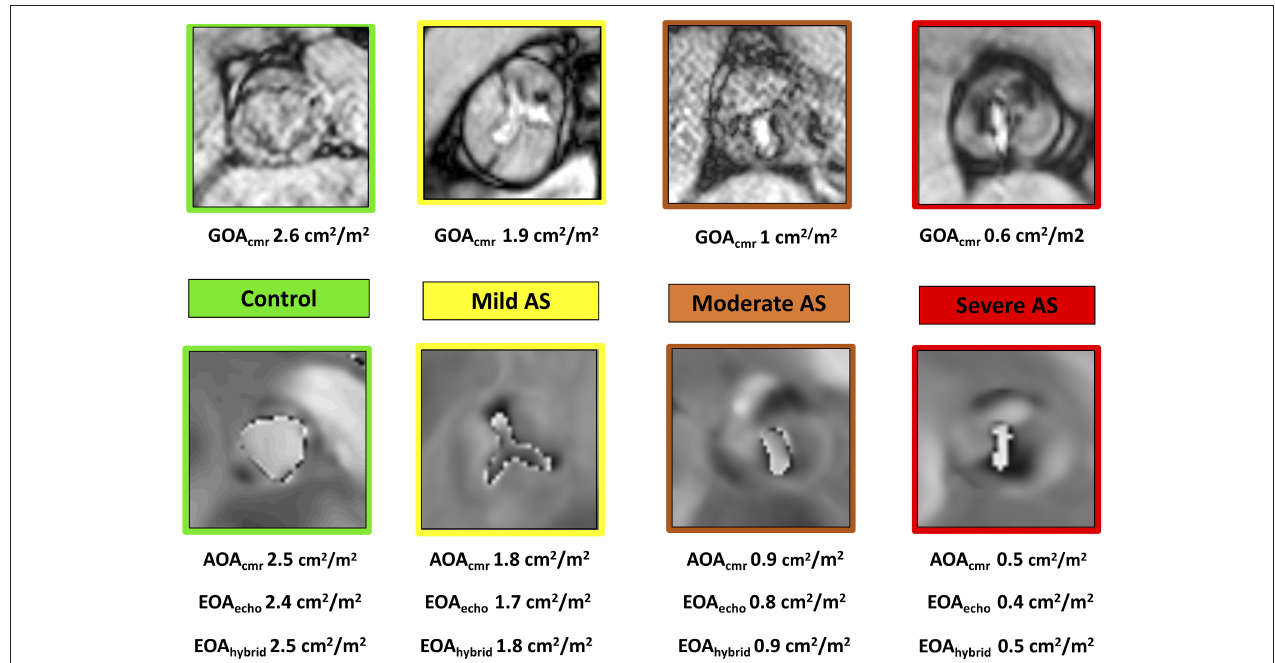
FIGURE 2 | Case examples of normal aortic valve area (green), mild (yellow), moderate (orange), and severe (red) aortic stenosis measured with GOA planimetry (top row) by cine CMR and AOA planimetry by fixed low-VENC phase contrast CMR (bottom row). All measurements have been indexed to body surface area and reported as cm 2 /m 2 . AOA, aliased orifice area; EOA, effective orifice area; CMR, cardiovascular magnetic resonance; GOA, geometric orifice area; echo, echocardiography; hybrid, combined echo-CMR